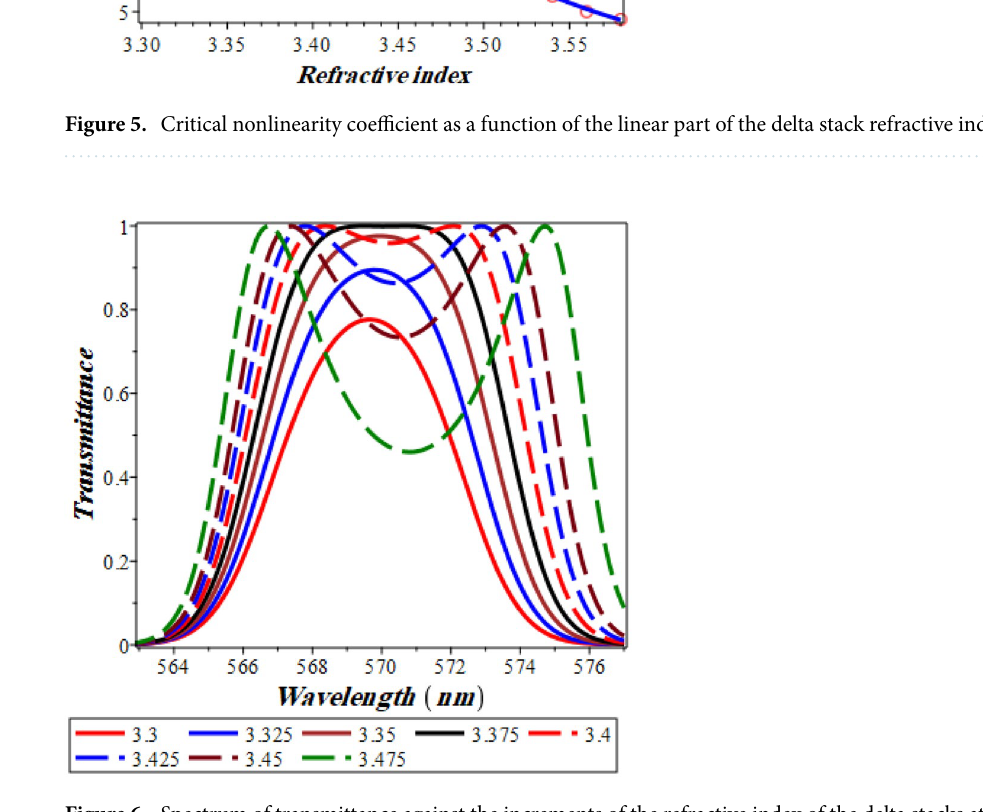
Figure 6. Spectrum of transmittance against the increments of the refractive index of the delta stacks at constant value of the nonlinearity coefficient = − 2 × 10 −7 (V/m) −2